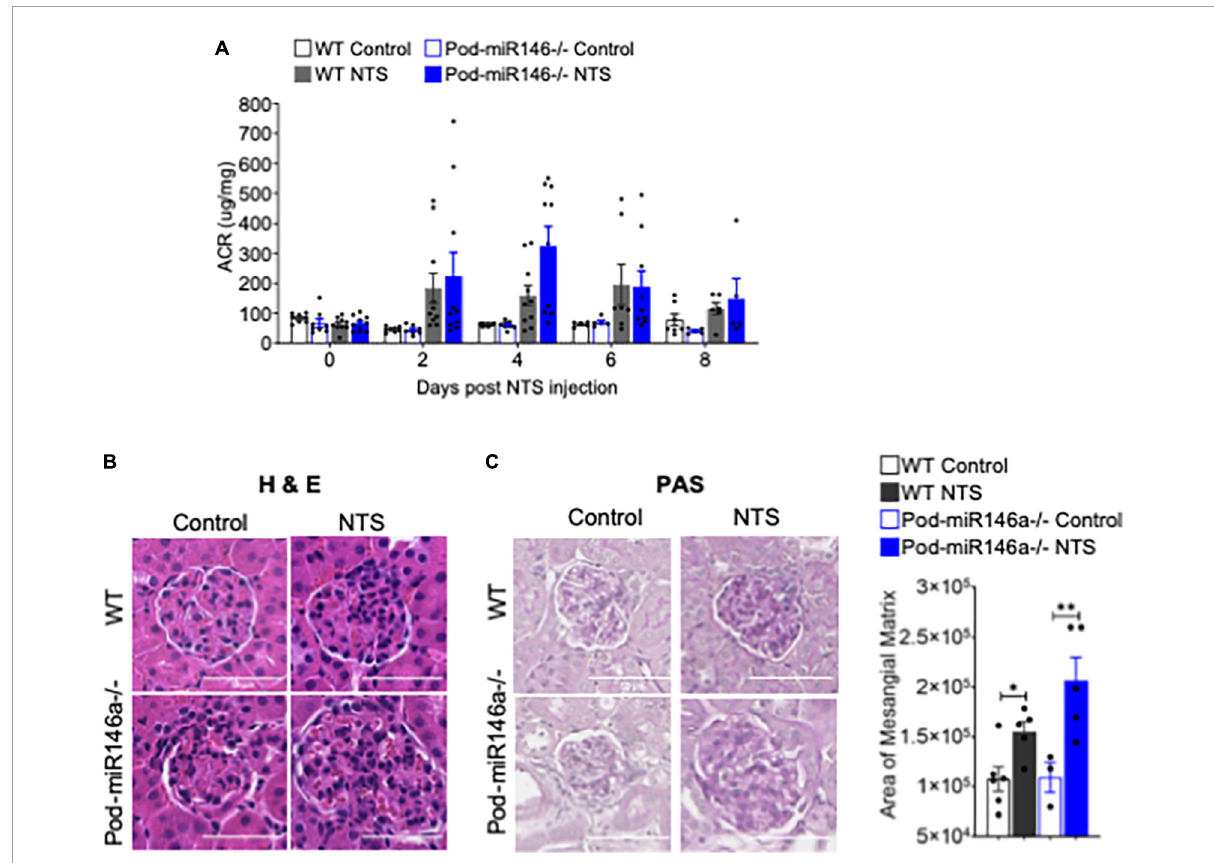
FIGURE3 Increased albuminuria in Pod-miR-146a − / − mice after NTS treatment. (A) Graph showing the albumin to creatinine ratio ( µ g/mg) in the urine of WT (gray bars) and Pod-miR-146a (blue bars) mice post administration of either vehicle (open bars) or NTS (shaded bars) at various time-points, as indicated. Statistics were performed using two-way ANOVA. Data shown are mean ± SEM ( n = 5). Representative images showing histochemical analyses with (B) H&E and (C) PAS staining of kidney tissues from each of the four groups of animals from 8th day post NTS treatment. Scale bar, 50 µ m. Graph showing quantified mesangial matrix from the PAS-stained sections. Statistics were performed using the Mann-Whitney test. Data shown are normalized to the level of staining in control tissue and are mean ± SEM ( n = 3). * p < 0.05; ** p <